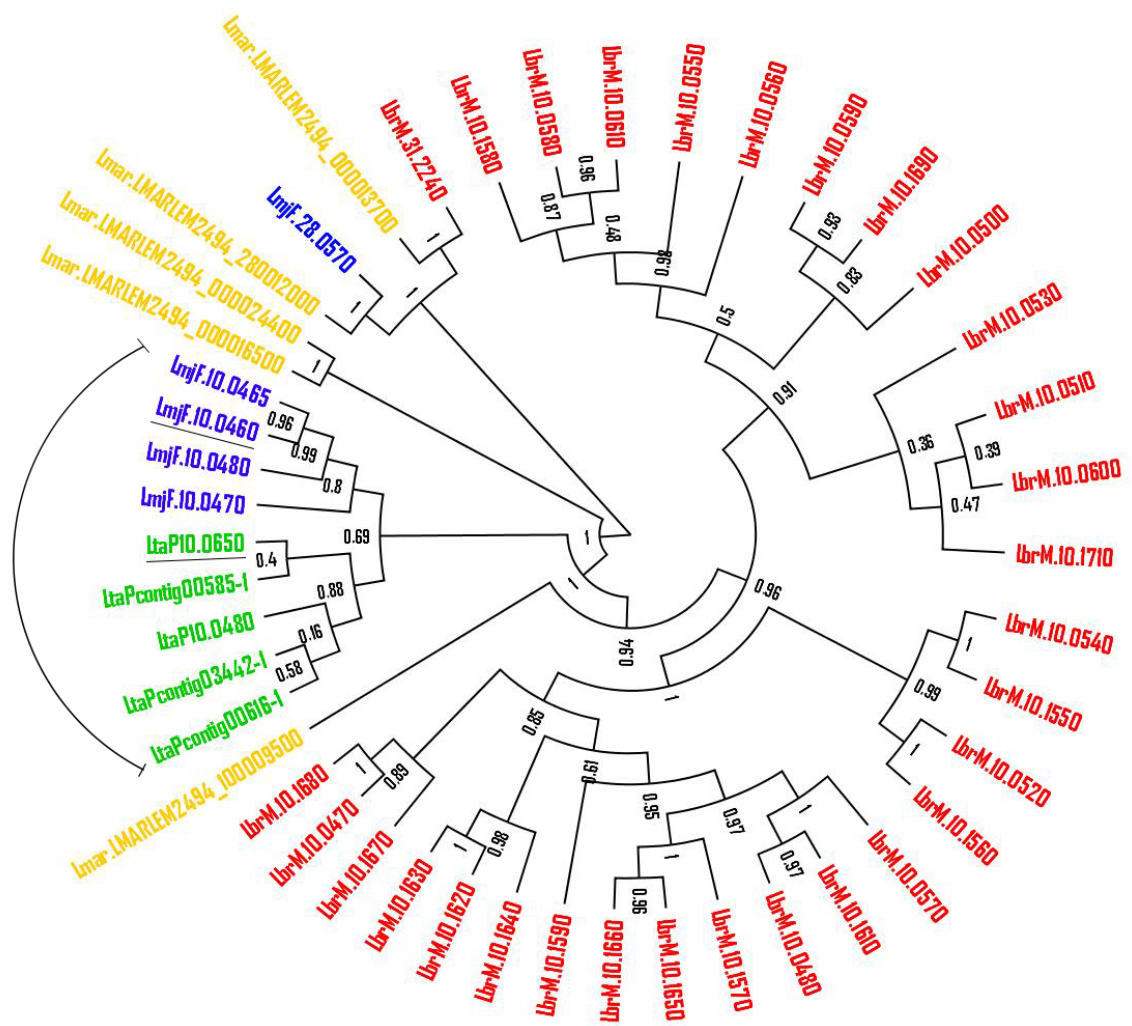
Figure 1. Unrooted maximum likelihood phylogenetic tree using leishmanolysin protein se- quences. L. major , L. braziliensis , L. martiniquensis , and L. tarentolae protein sequences annotated as “leishmanolysin” were obtained from TriTrypDB and were analyzed by Interproscan v5.16-55 to confirm the presence of LSHMANOLYSIN(PR00782) and Peptidase_M8(PF01457) domains. The sequences containing more than 200 residues were aligned and a phylogeny reconstruction based on Maximum Likelihood, Jones-Taylor-Thornton (JTT) was performed and visualized in Dendroscope v3.5.7. Numbers shown at branch nodes are bootstrap values based on 1000 replicates. The closed relation of L. tarentolae and L. major leishmanolysins are indicated, as well as the underlined leishmanolysins selected to be